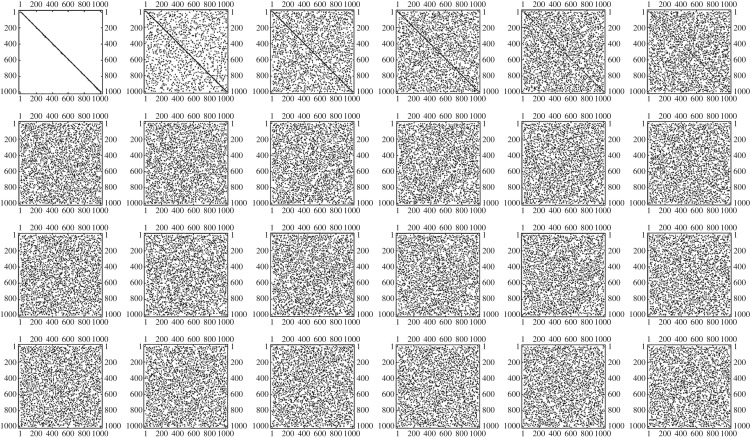
A random walk through Hn with n=1000, starting from a range-dependent random graph [39] where edge (vi,vj) (i≠j) is present with probability pij=(13)(|i−j|−1) so both in and out degrees have an expected value of z=3 (there are actually 3018 edges). There are 1000 edge swaps (successive applications of F) between each successive graph. We show the adjacency matrices for successive graphs.